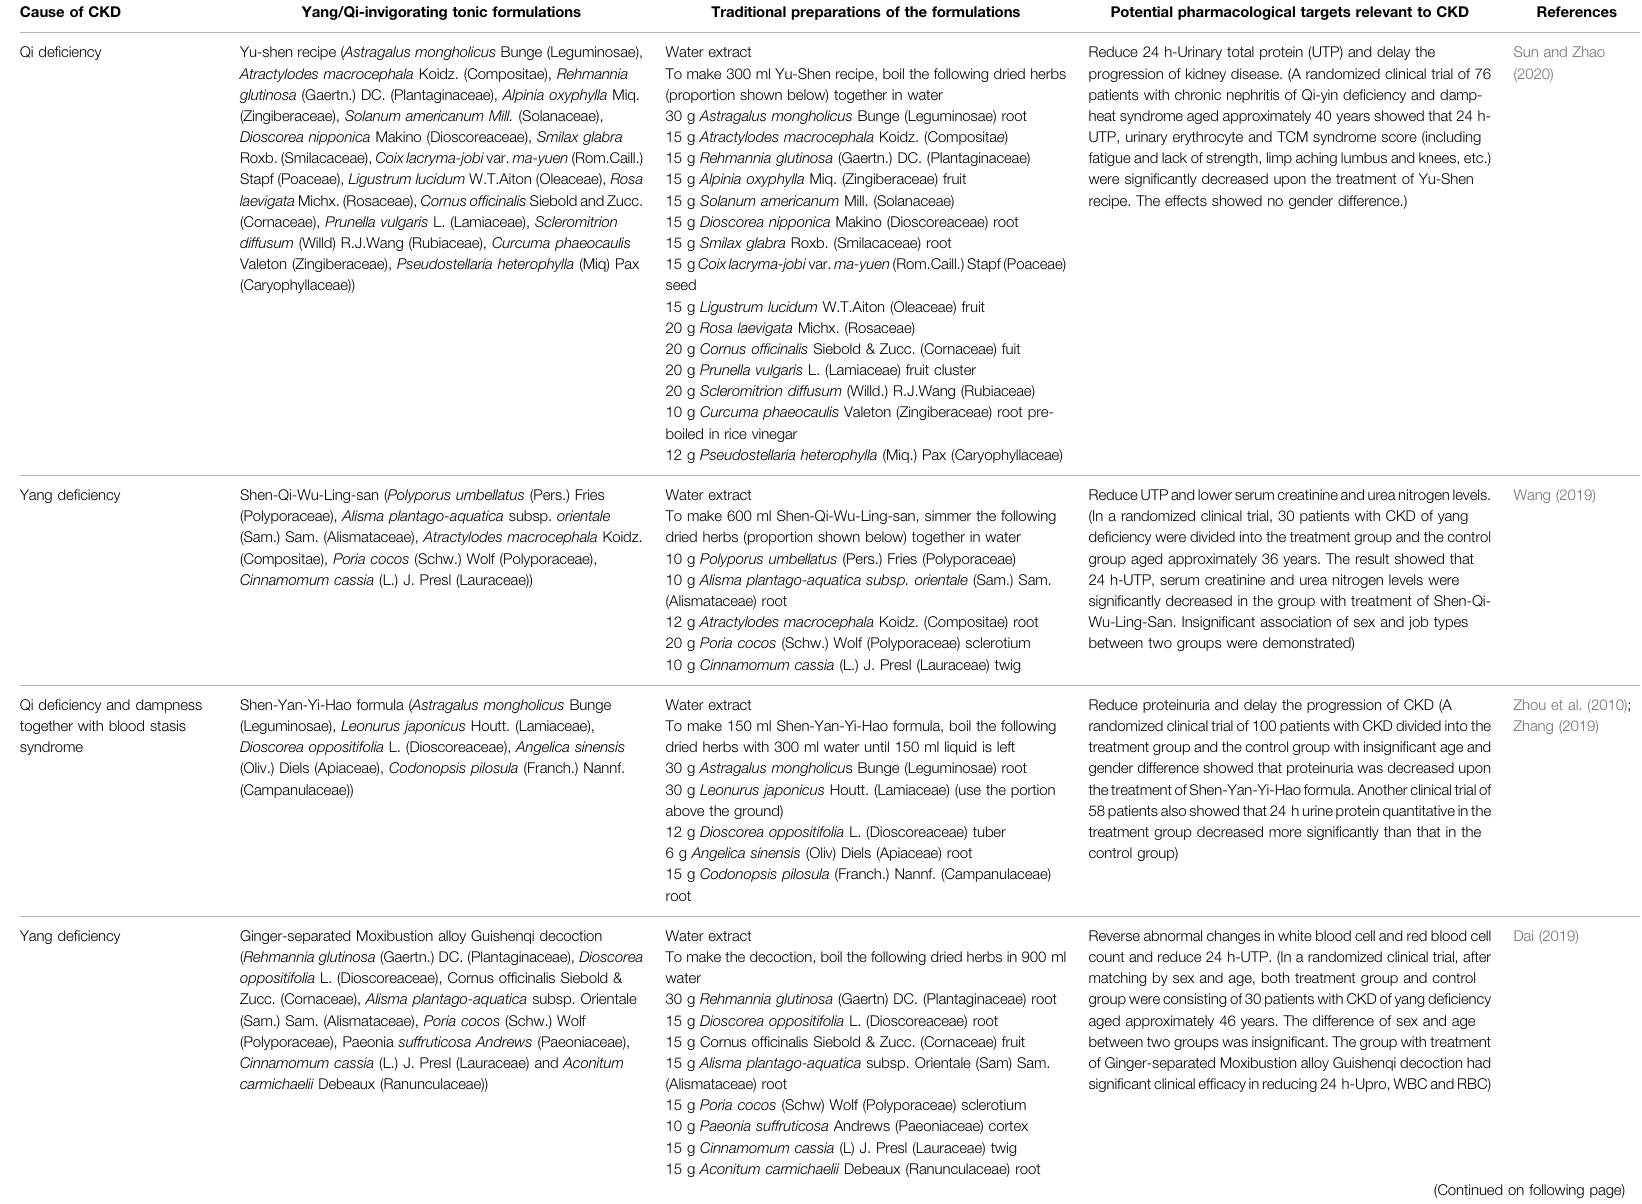
TABLE 1 | Effects of Yang/Qi-invigorating formulations on the treatment of CKD. Cause of